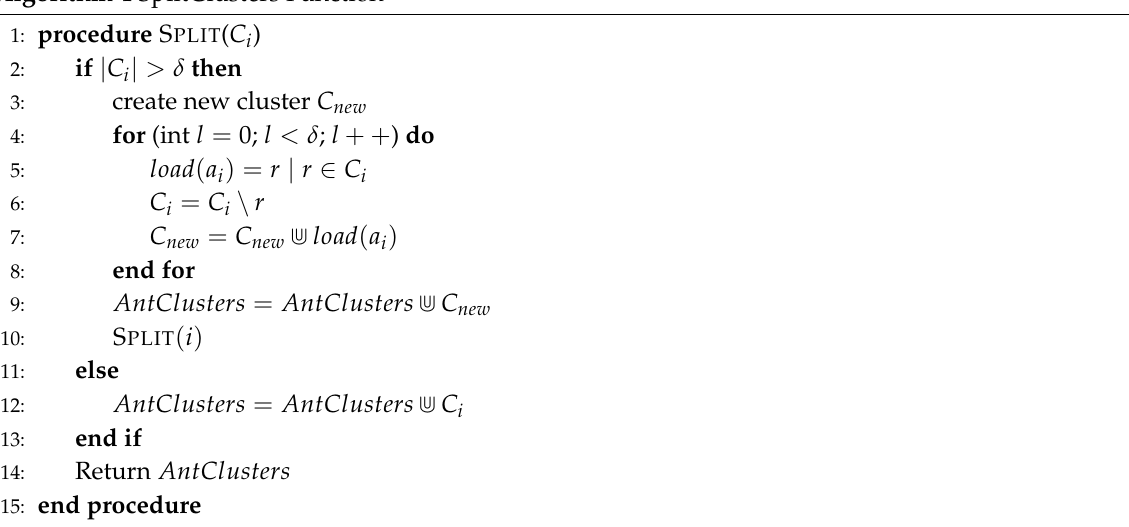
Algorithm 4 SplitClusters Function